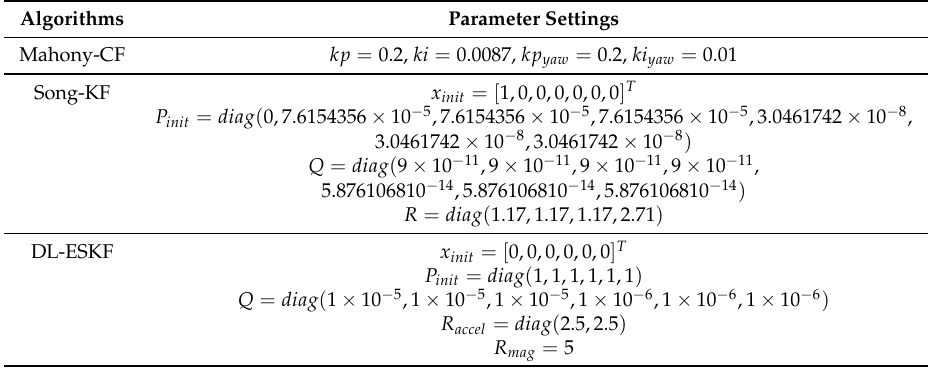
Table 6. The parameter settings of the Mahony-complementary filtering (CF), Song-Kalman filter (KF), and the proposed double-layer error-state Kalman filter